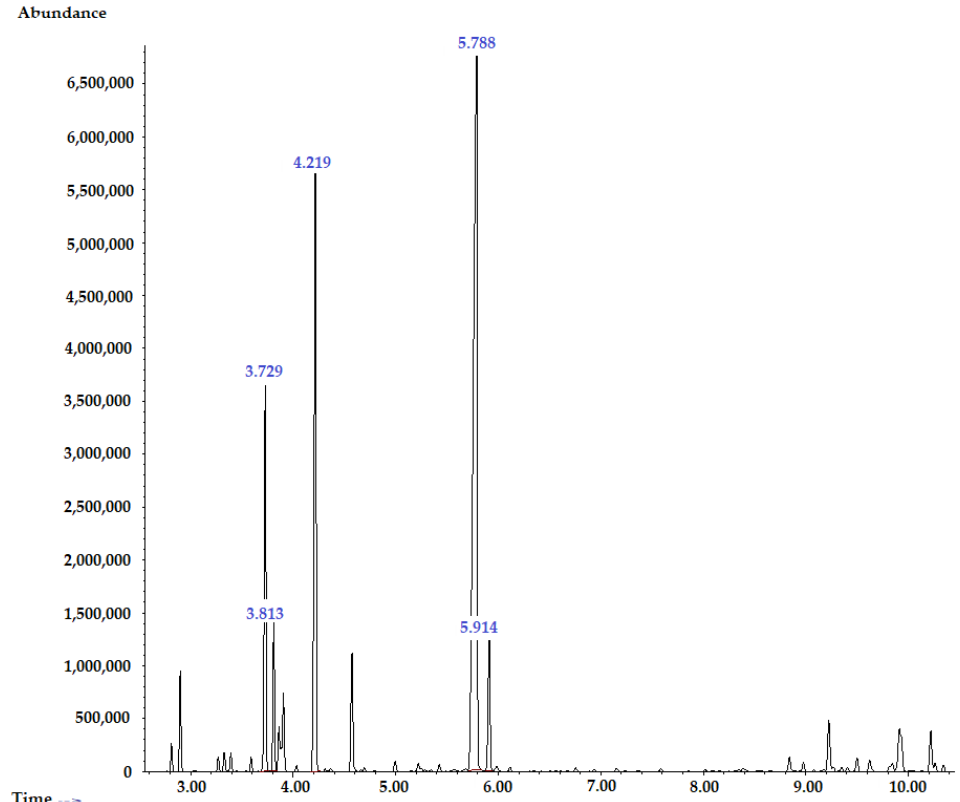
Figure 1. GS/MS chromatogram of TTO. Most of TTO phytoconstituents were thujen, α -pinene, β -pinene, myrcene, α -terpinene, o-cymene, D-limonene, 1,8-cineole, γ -terpinene, terpinolene, terpinen-4-ol, α -terpineol, aromadendrene, viridiflorene (ledene), and δ -cadiene. The identified compounds belonged to the monoterpene and sesquiterpene chemical classes (Table 1).